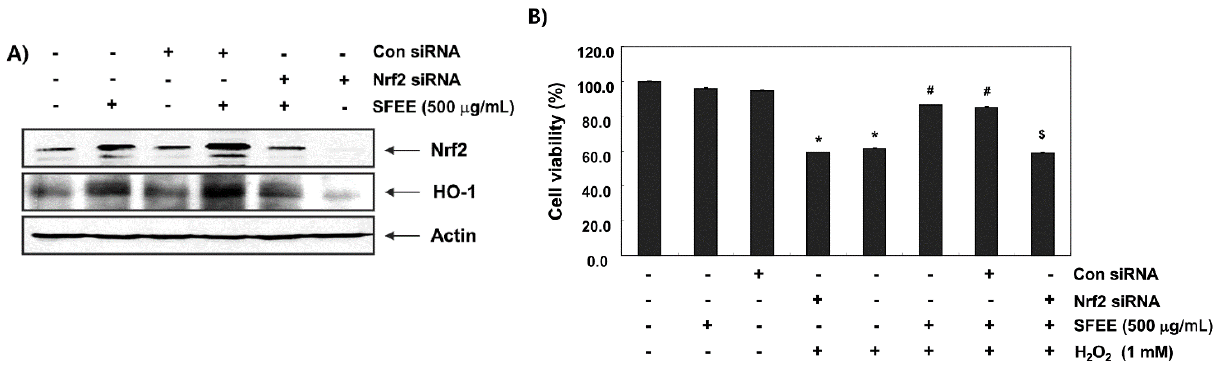
Figure 6. Nuclear factor-erythroid 2 related factor 2 (Nrf2)-mediated induction and heme oxygenase-1 (HO-1) expression by Schisandrae Fructus ethanol extract in C2C12 cells. Cells were transfected with control small interfering RNA (siRNA) and Nrf2 siRNA. After 24 h, the cells were treated with 500 μg/mL Schisandrae Fructus ethanol extract (SFEE) for 6 h ( A ) or pretreated with 500 μg/mL SFEE. for 1 h and then stimulated with or without 1 mM H 2 O 2 for 6 h ( B ). ( A ) Cellular proteins were separated on SDS-polyacrylamide gels and transferred to nitrocellulose membranes. The membranes were probed with specific antibodies against Nrf2 and HO-1. ( B ) Cell viability was estimated by the 3-(4,5- dimethylthiazol-2-yl)-2,5-diphenyltetrazolium bromide (MTT) assay. Results are mean ± SD values obtained from three independent experiments ( * p < 0.05 compared with control group; # p < 0.05 compared with H 2 O 2 -treated group; $ p < 0.05 compared with H 2 O 2 and SFEE-treated